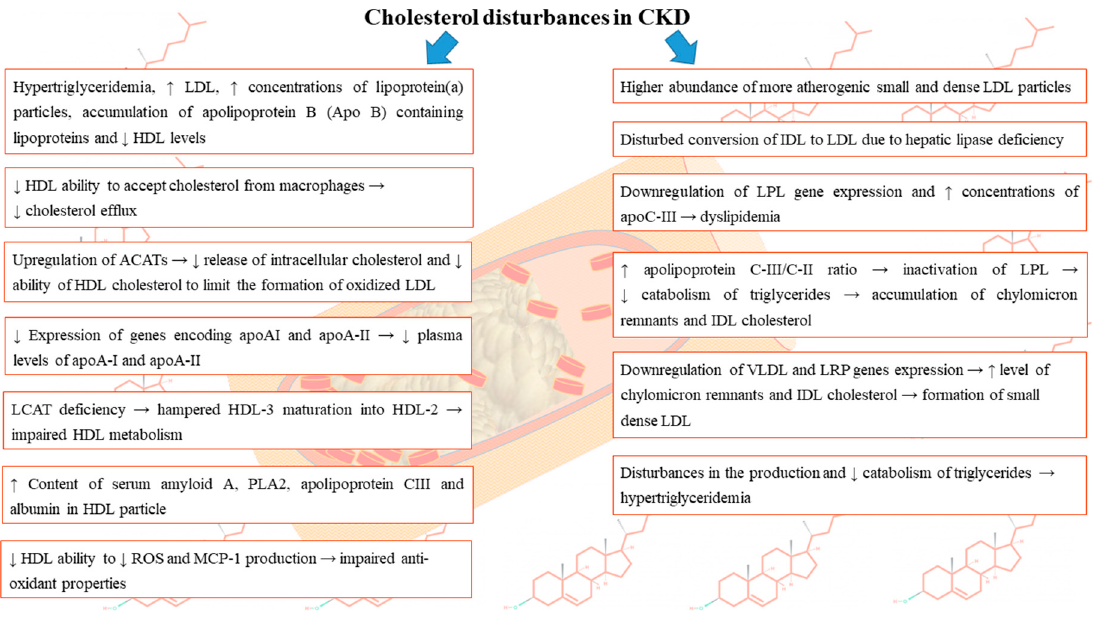
Figure 1. Summary of disturbances in lipoproteins levels occurring in the course of